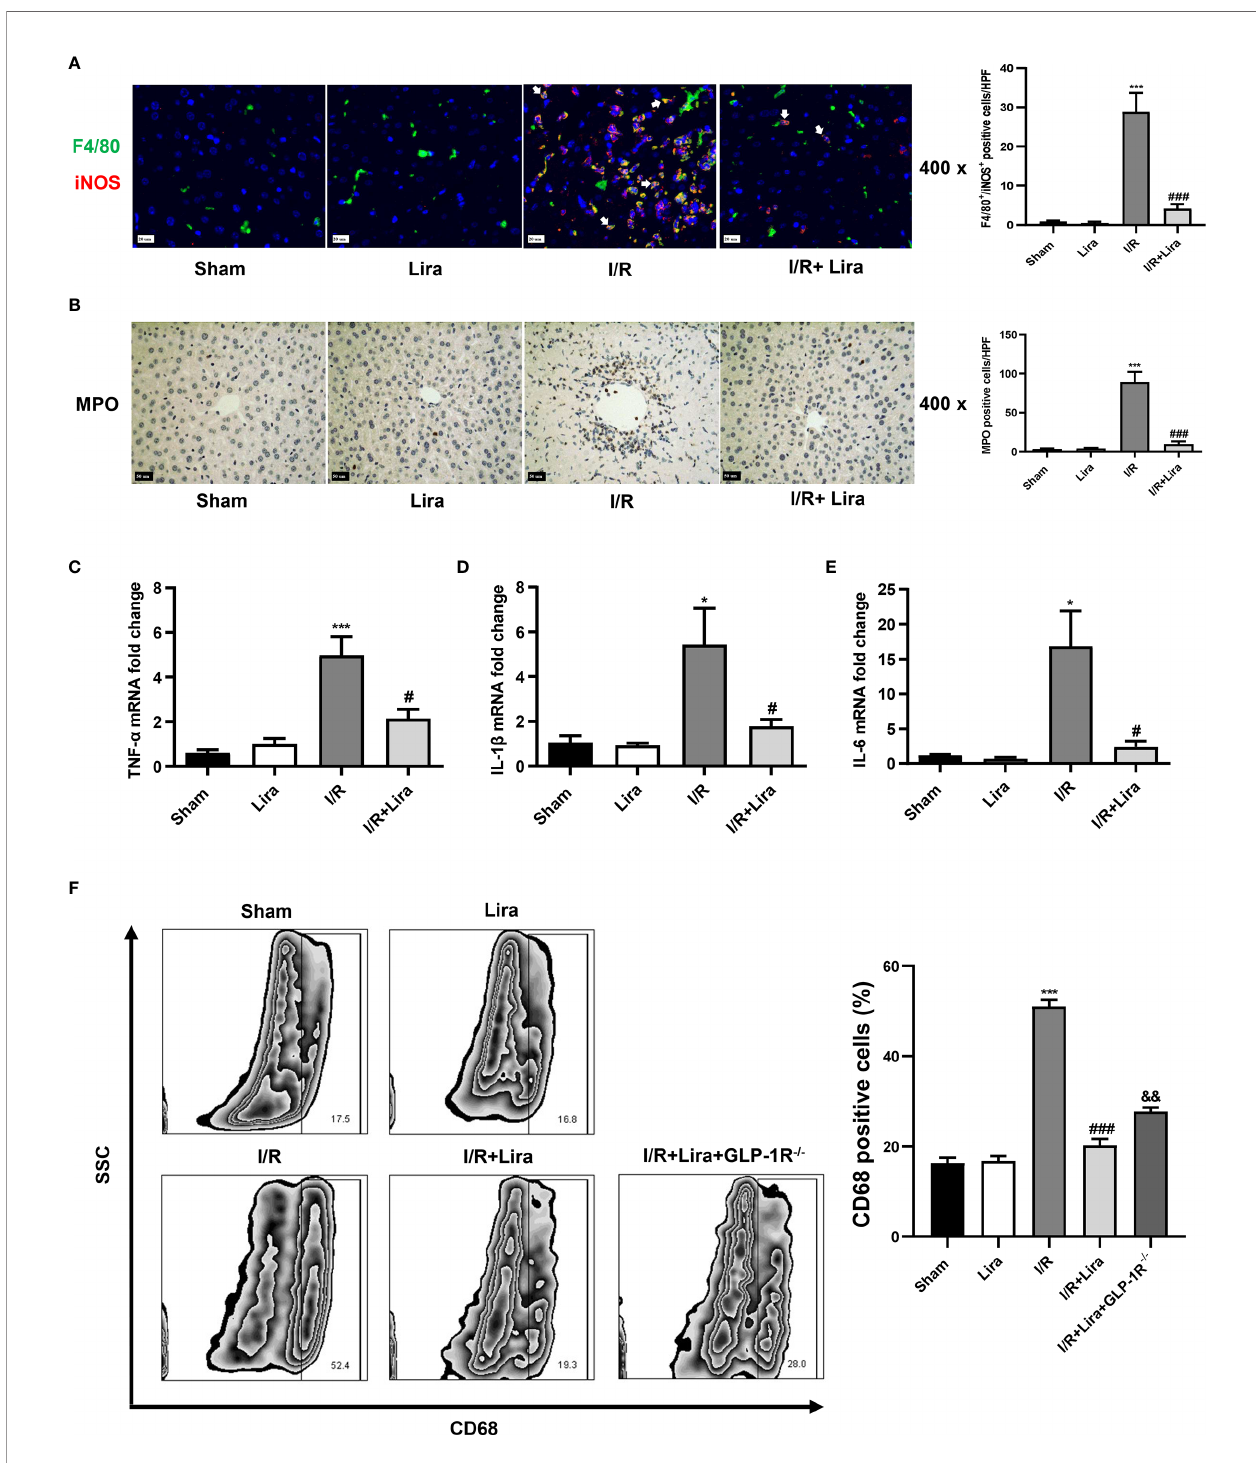
FIGURE 4 | Liraglutide pretreatment inhibits I/R-elicited M1 polarization of KCs in the liver. Mice underwent 60 min of liver ischemia and 6 h of reperfusion; liver tissues were harvested for immuno fl uorescence staining (A) and MPO staining (B) (original magni fi cation 400×), and the number of F4/80 + /iNOS + positive cells and MPO-positive cells was calculated. The expression of pro-in fl ammatory cytokines, including TNF- a (C) , IL-1 b (D) , and IL-6 (E), in the liver was detected via qRT- PCR. (F) The number of CD68 + -positive cells of KCs under F4/80 + and CD11b + subsets was calculated via fl ow cytometry. The results represent the means from at least 3 independent experiments. Values are shown as mean ± SD, n = 3 per group. *P < 0.05, ***P < 0.001 vs. the Sham group; # P < 0.05, ### P < 0.001 vs. the I/ R group. && P < 0.01 vs. the I/R+Lira group. KCs, resident macrophages; MPO,